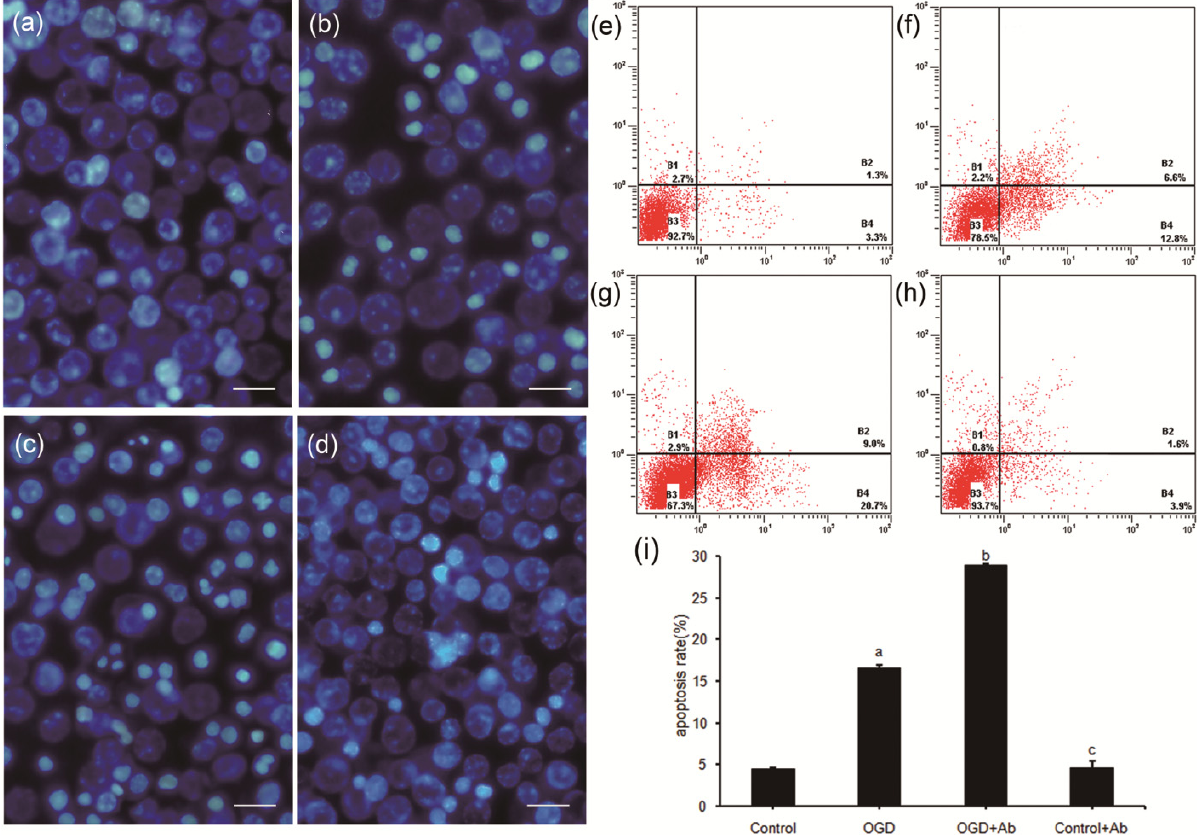
Figure 3. ActRII-Ab augmented injury in PC12 cells subject to 3 h OGD. ( a – d ) Morphological changes of apoptotic cells detected by Hoechst 33342 staining (bar = 50 μ m). ( a ) Control group, no severe morphological changes of apoptosis. ( b ) OGD group, few apoptotic cells with stronger blue fluorescence or chromatin condensation. ( c ) OGD+Ab group, more apoptotic cells were found. ( d ) Control+Ab group, no significant difference compared to Control group. ( e – i ) Apoptotic rate determined by flow cytometry analysis with the Annexin V/PI double staining assay. Early apoptotic cells were shown in the lower right quadrant, late apoptotic cells in the upper right quadrant. Figures represent one sample of three independent experiments. ( e ) Control group. ( f ) OGD group. ( g ) OGD+Ab group. ( h ) Control+Ab group. ( i ) Apoptotic rate in OGD group was higher than Control group (16.62 ± 0.78% vs. 4.47 ± 0.13%, a: p < 0.05), which was even increased in OGD+Ab group (28.96 ± 0.92% vs. 16.62 ± 0.78%, b: p < 0.05). There was no significant difference between Control and Control+Ab group (4.47 ± 0.13% vs. 4.58 ± 0.85%, c: p >